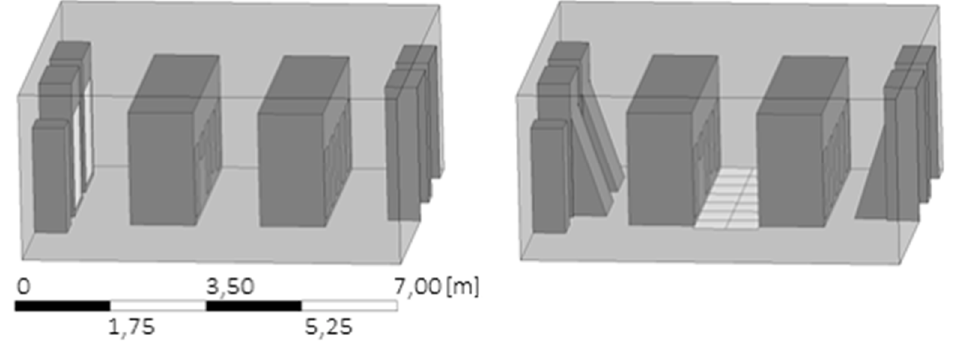
Figure 1. Computational domain for (left) the hard floor configuration and (right) the raised floor configuration with open aisles.